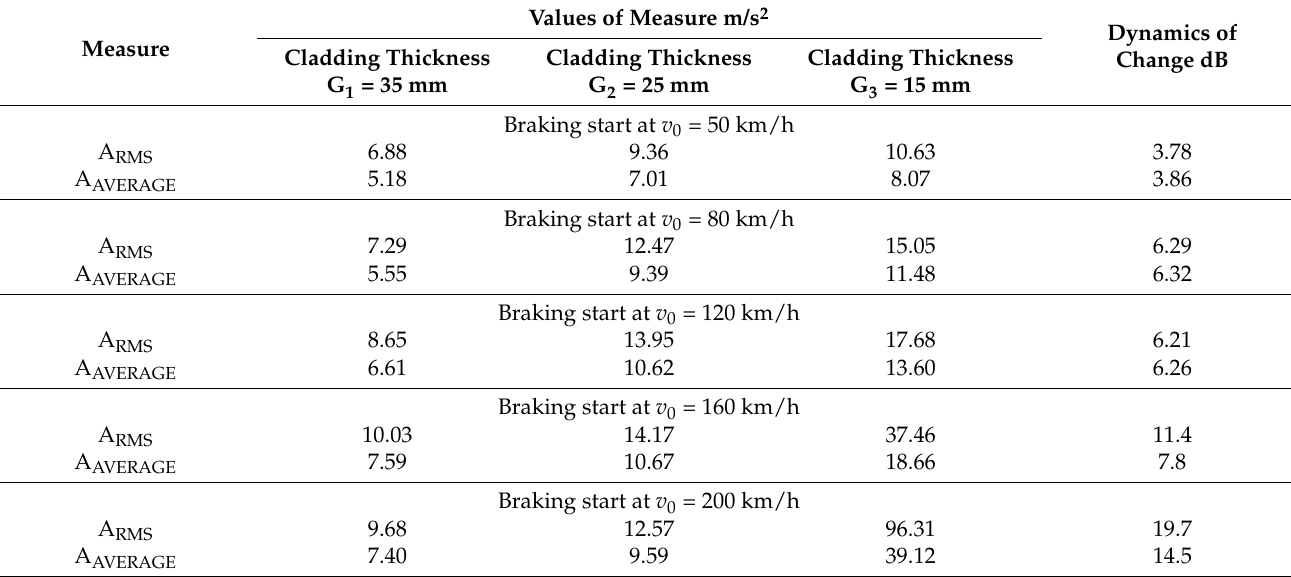
Table 1. The values of the measures of the vibration acceleration of the friction linings depending on the speed of braking and the wear of the friction linings, along with the dynamics of changes.